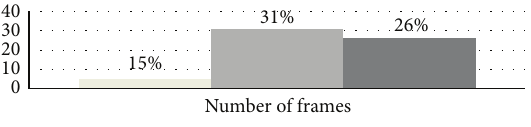
Figure 10: Detection rate or precision rate.